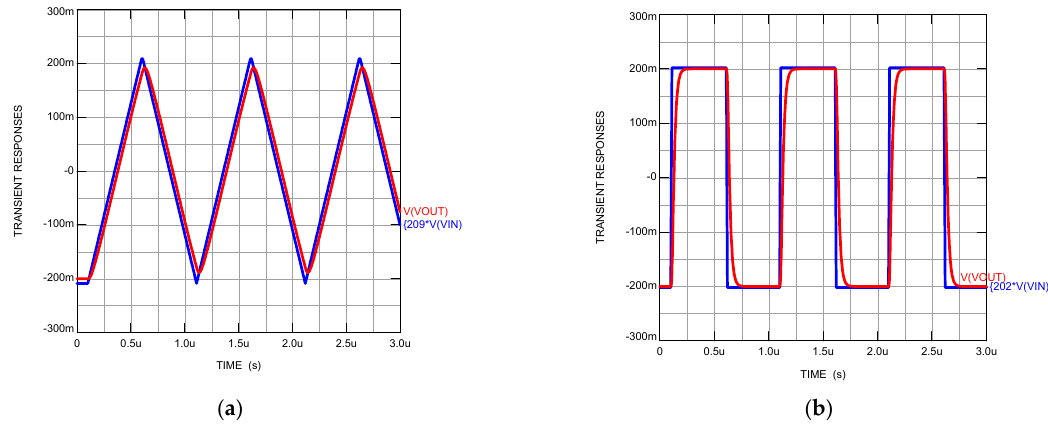
Figure 15. Transient response of circuit of Figure 13 ( a ) with triangular input signal, ( b ) with pulse input signal.